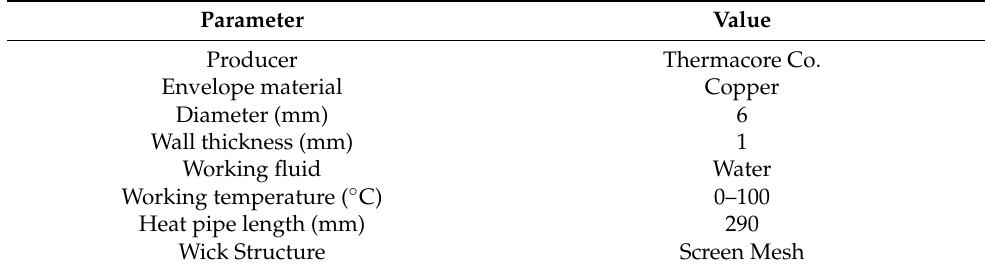
Table 2. The important properties of the PCM